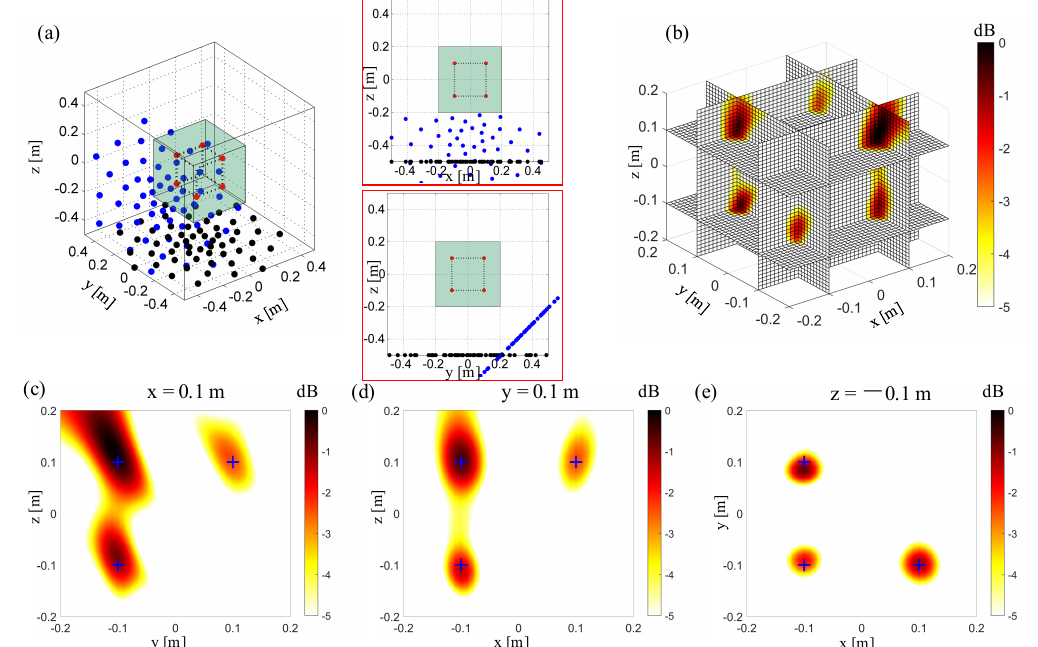
Figure 9. 3D Beamforming results from the non-synchronous measurements, non-orthogonally moving the array once. ( a ) The simulation setup. The red points “ · ” represent the sound sources. The other same color represents the microphones in the same test. The black points “ · ” represent the microphones in a single planar array test. The blue points “ · ” represent the microphones in the test with the non-orthogonal moving array, moved here for the first time. The first subfigure represents the view in the x–z plane, and the second subfigure represents the view in the y–z plane. ( b ) 3D beamforming map. ( c ) The beamforming map at the x = 0.1 m slice. ( d ) The beamforming map at the y = 0.1 m slice. ( e ) The beamforming map at the z = − 0.1 m slice.